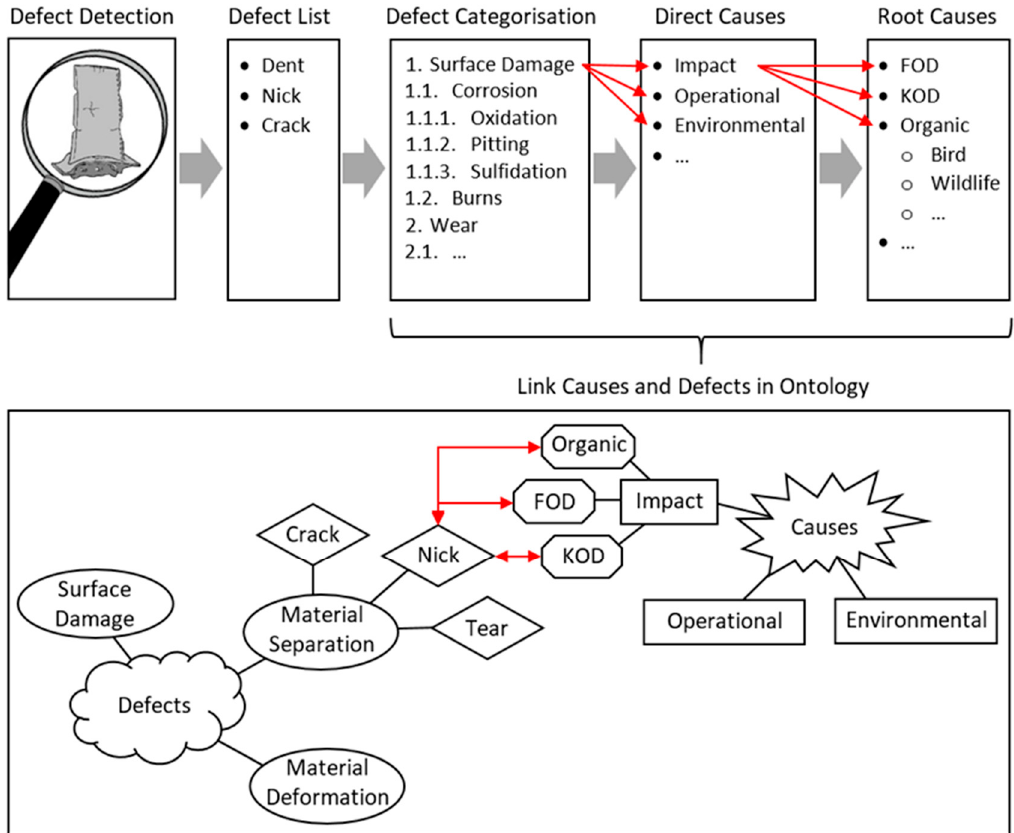
Figure 1. Research approach.